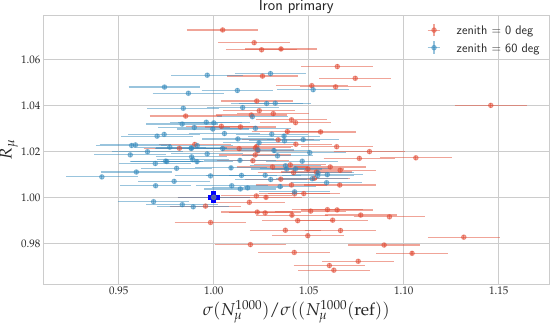
Figure 5. Results of simulations in [ σ ( N 1000 proton primary.